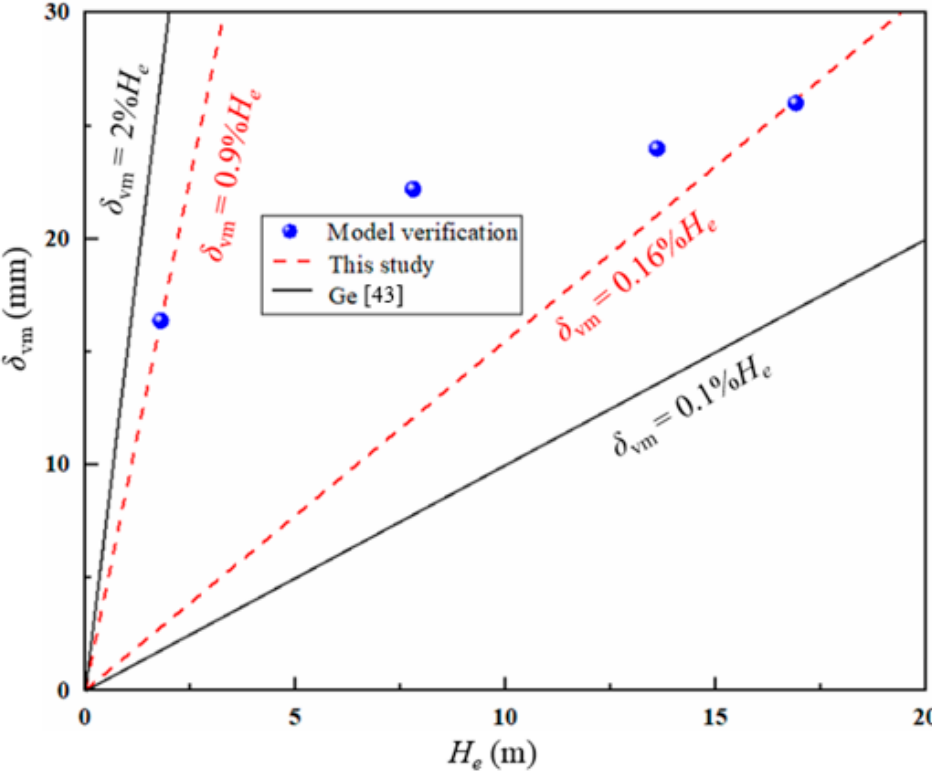
Figure 3. Relationship between maximum ground settlement and final excavation depths.